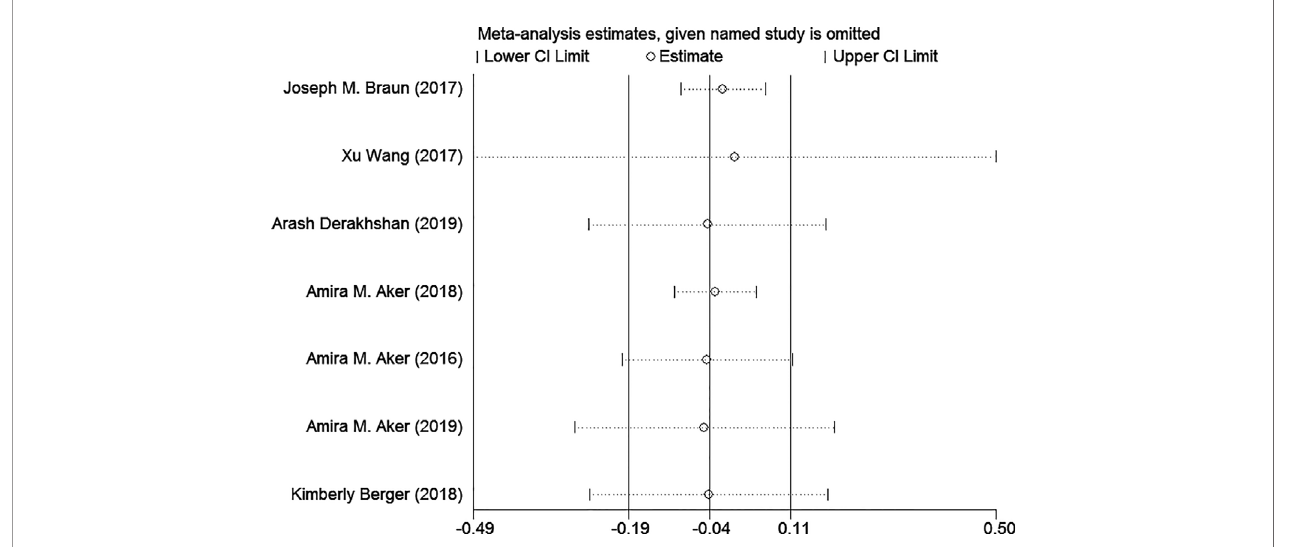
FIGURE 8 | Sensitivity analysis of prenatal exposure to TCS and maternal thyroid hormone